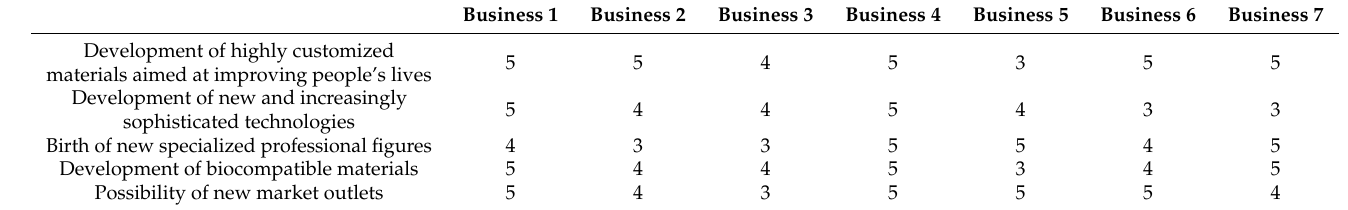
Table 6. Current and future opportunities generated by the application of 3D printers in the medical field.